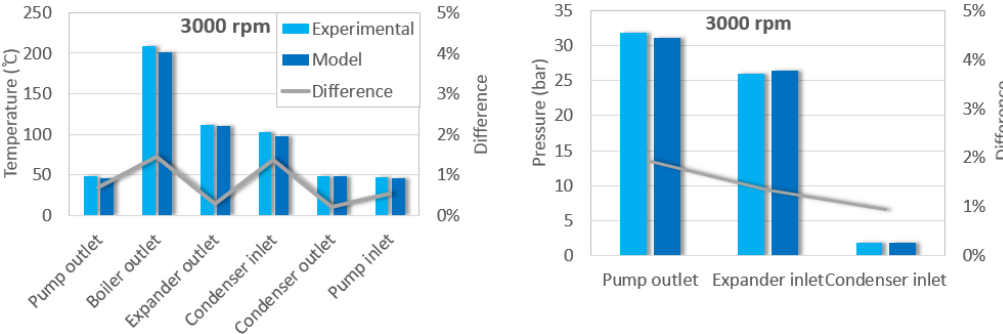
Figure 11. Validation of 2500 rpm.